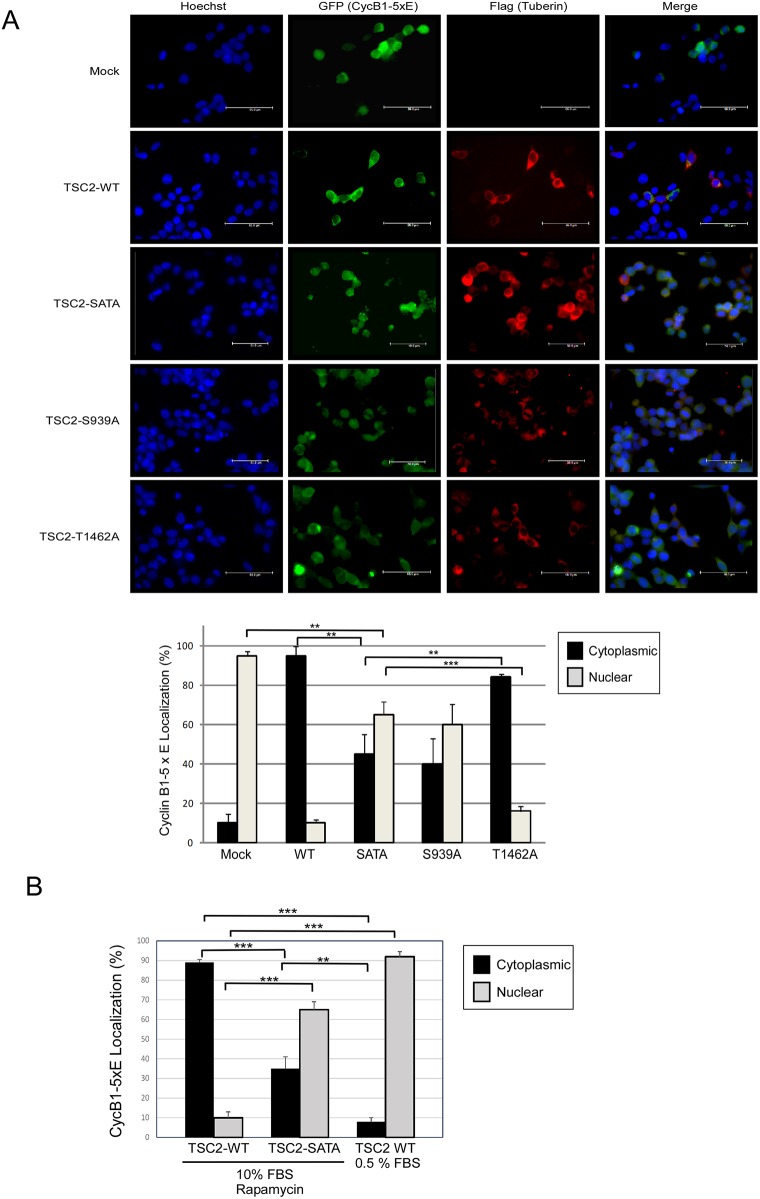
Akt phosphorylation of Tuberin regulates the localization of CycB1 and mitotic onset.HEK293 cells transfected with CycB1-5xE-GFP were co-transfected with either empty vector (Mock), TSC2-WT, TSC2-SATA, TSC2-S939A or TSC2-T1462A. (A: top panel) Representative immunocytochemistry showing Hoechst (Blue; first column), CycB1-GFP (Green; second column), Flag-TSC2 Texas Red (red; third column) and merge (last column). (A: bottom panel) Graph represents the percentage of CycB1-5xE found in the cytoplasm (solid bars) or nucleus (grey bars). Errors represent SD over 3 separate transfections. Unpaired t-test, ** p< 0.01 and *** p < 0.001. (B) HEK293 cells transfected with CycB1-5xE-GFP were co-transfected with TSC2-WT or TSC2-SATA. 18 hrs following transfection, cells were washed with PBS and incubated for 2 hrs with 0.5% or 10% FBS, followed by the addition of either vehicle control or Rapamycin (100nM) for 4 hrs prior to lysis. Graph shows the percentage of CycB1-5xE localized to the cytoplasm (solid bars) or nucleus (grey bars). Error bars represent SD over 3 separate transfections. Unpaired t-test, ** p< 0.01 and *** p>0.001.